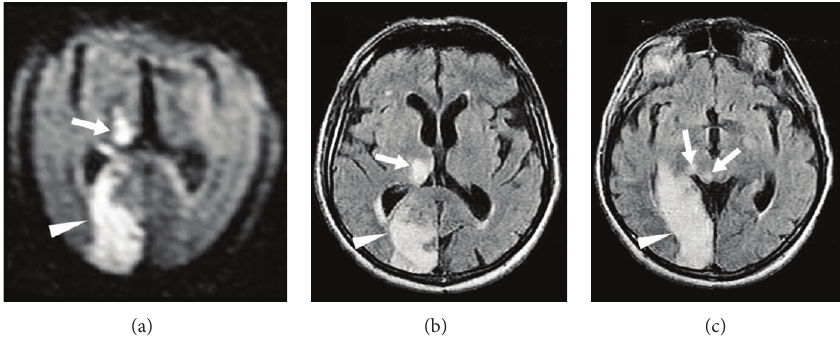
Figure 3: DWI (a) and FLAIR (b and c) imaging showing infarctions involving the territories of the right-sided posterior choroidal artery (a and b, arrows), the posterior cerebral artery (a, b, and c, arrowheads), the collicular artery, and the posteromedial choroidal artery (c, arrows).